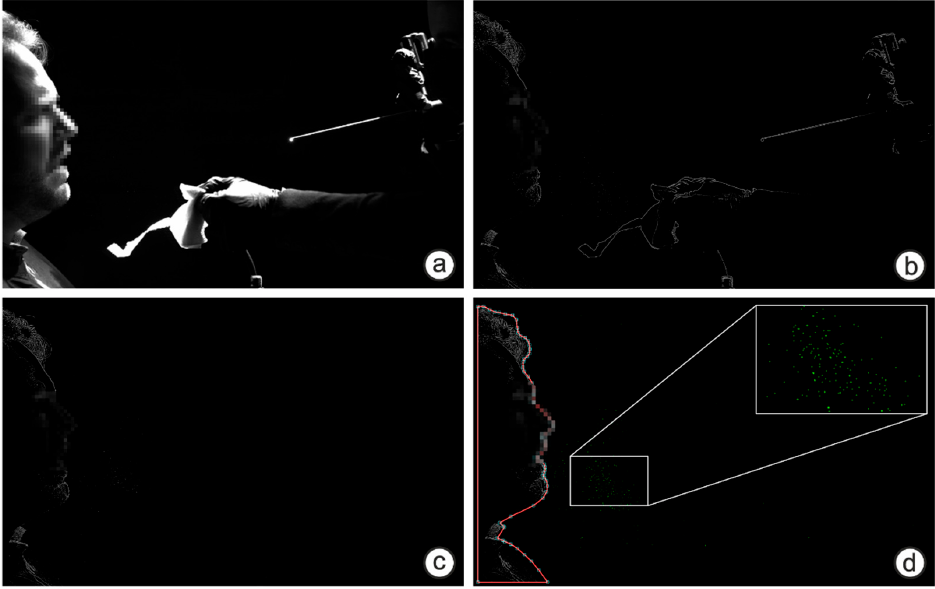
Figure 3. Image processing pipeline for one exemplary frame; ( a ) Unedited image with subject on the left and physician on the right handside; ( b ) Edge high pass filtered image from the software PCC 2.6 ( c ) Image where the physician was cut out with Sensarea ( d ) Masked subject and detected/tracked particles (green). An enlarged image section of the tracked droplets is shown in the upper right